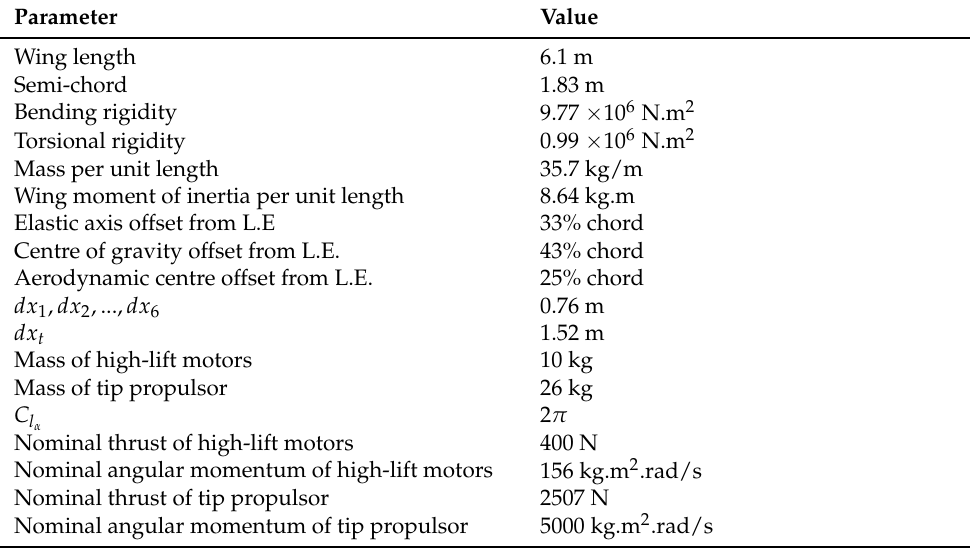
Table 1. Properties of the aeroelastic system.